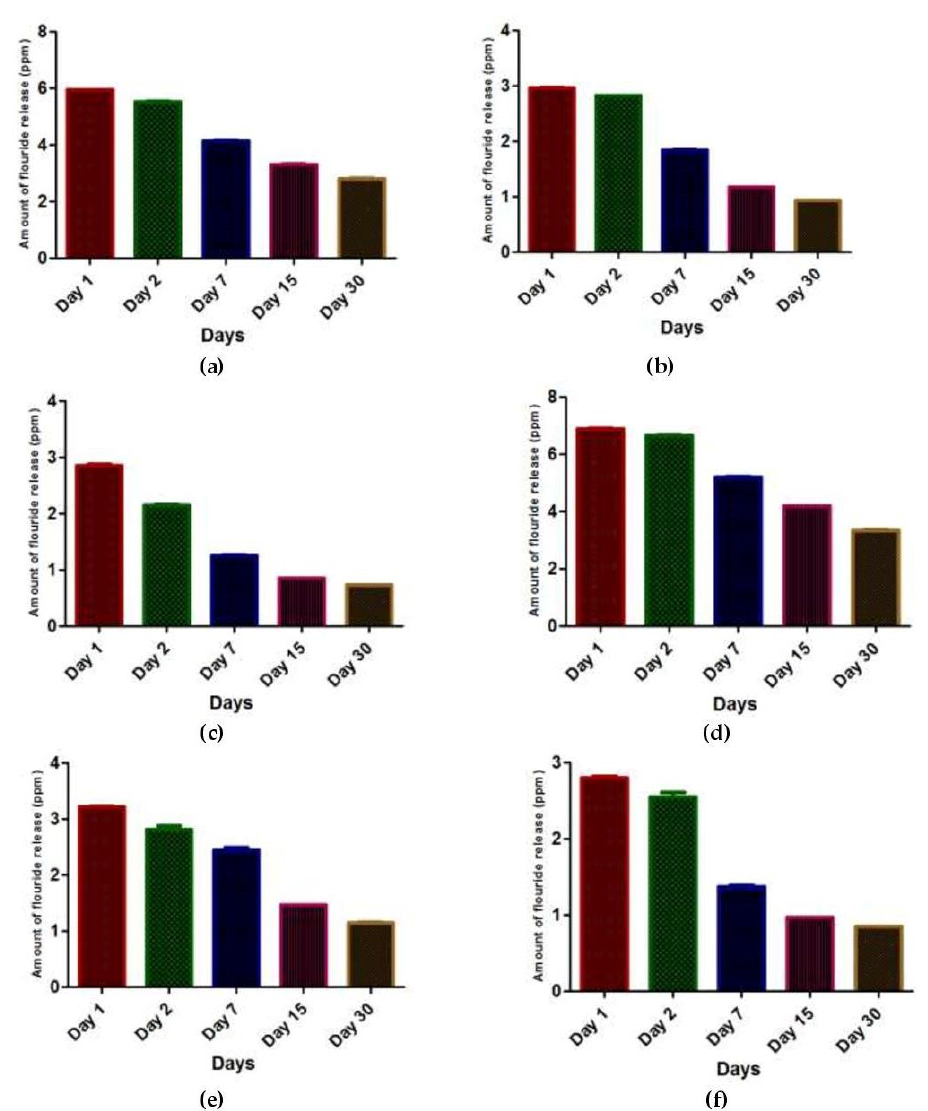
Figure 1. Mean values of fluoride release in ( a ) Group 1 (control group with no recharge); ( b ) Group 2 (0.1% silver nanoparticles with no recharge); ( c ) Group 3 (0.2% silver nanoparticles with no recharge); ( d ) Group 4 (control group with fluoride recharge); ( e ) Group 5 (0.1% silver nanoparticles with fluoride recharge); and ( f ) Group 6 (0.2% silver nanoparticles with fluoride recharge) on days 1, 2, 7, 15, and